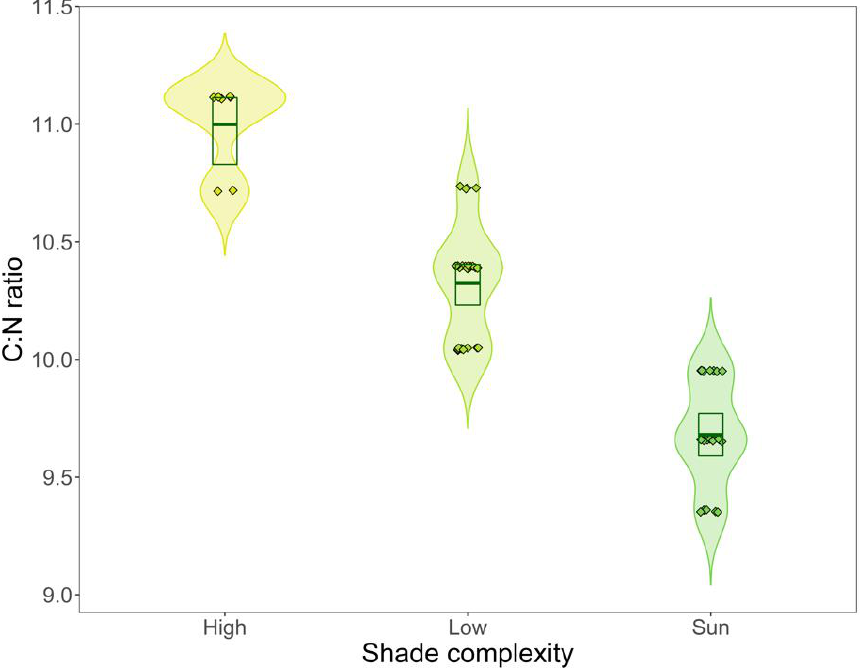
Figure 4. C:N ratio of soil samples from 56 coffee home gardens in West Java in relation to shade complexity of gardens (High: >10% shade cover and ≥5 shade tree species; Low: >10% cover and <5 shade tree species; Sun: <10% shade cover). Data are model predicted values from generalised linear models, and boxes dictate 95% confidence intervals.